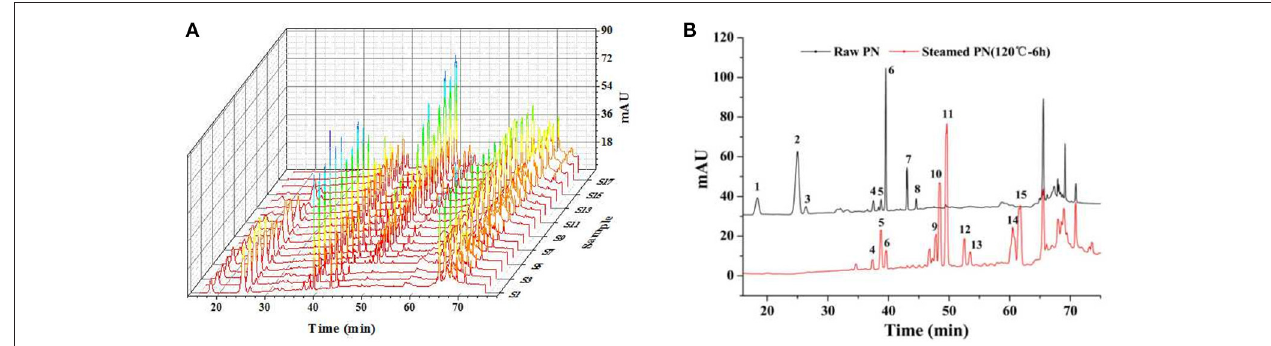
FIGURE 1 | HPLC fingerprints (A) and the common peaks (B) of 18 batches of raw and steamed Panax notoginseng (PN) extracts. HPLC analyses were done on a Vision HT C 18 column (250 × 4.6mm, 5 µ m) at 30 ◦ C. The mobile phase consisting of (A) (ultra pure water) and (B) (MeCN) was used at a flow rate of 1.0 ml/min as the following gradient mode: 0–20min, 80% A; 20–45min, 54% A; 45–55min, 45% A; 55–60min, 45% A; 60–65min, 100% B; 65–70min, 80% A; 70–90min, 80% A. The detection wavelength was set at 203nm and the injection column was set at 10 µ L.